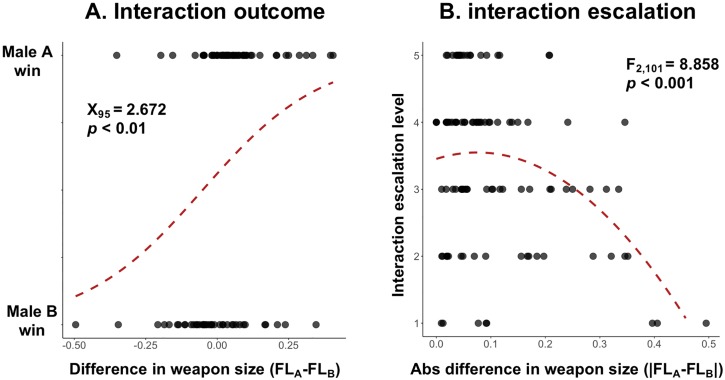
Interaction outcome and escalation in S. femorata.A) Interaction outcome. Red line represents logistical regression of interaction outcome (Male A or B wins) in relation to the difference in competitor weapon size (Femur length; FLA − FLB). Positive x values indicate Male A had a larger weapon size than the opponent. Negative x values indicate that Male B had a larger weapon size than the opponent. B) Interaction escalation. Red line represents generalized linear model between interaction escalation level and absolute difference in weapon size (Femur length; |FLA − FLB|).